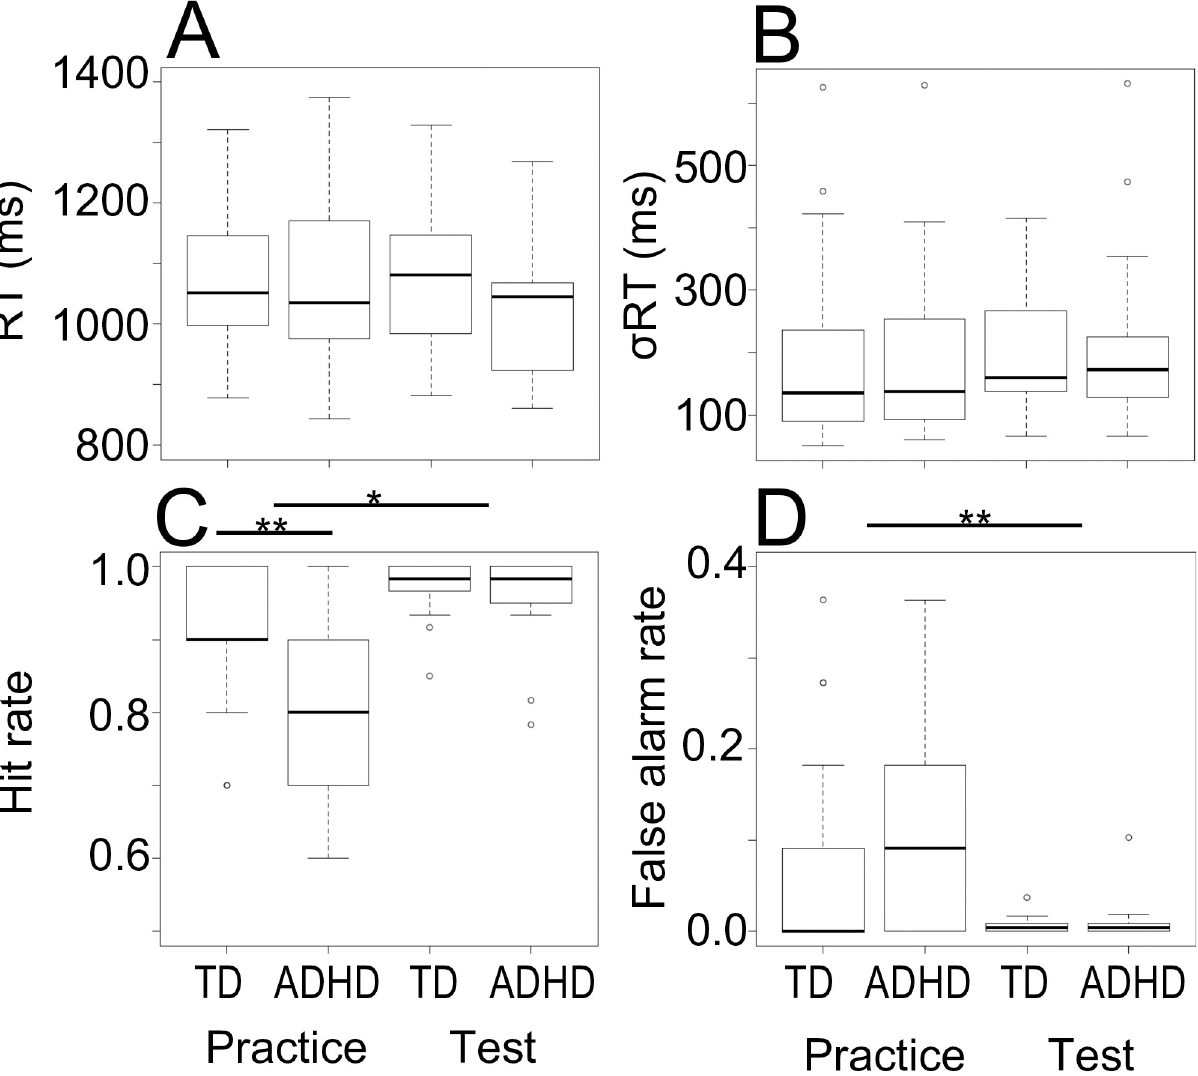
Fig 3. Behavioral performance on the aCPT across group (TD, ADHD) and phase (practice, test). (A) RT (ms), (B) σ RT (ms). (C) Hit rate. (D) False alarm rate. σ RT: reaction time variability (standard deviation), hit rate: the probability of correctly detecting a target on target trials, false alarm rate: the probability of falsely detecting a target on nontarget trials. These were assessed for statistically significant differences with a mixed-model ANOVA. � p < .05, �� p < .001.